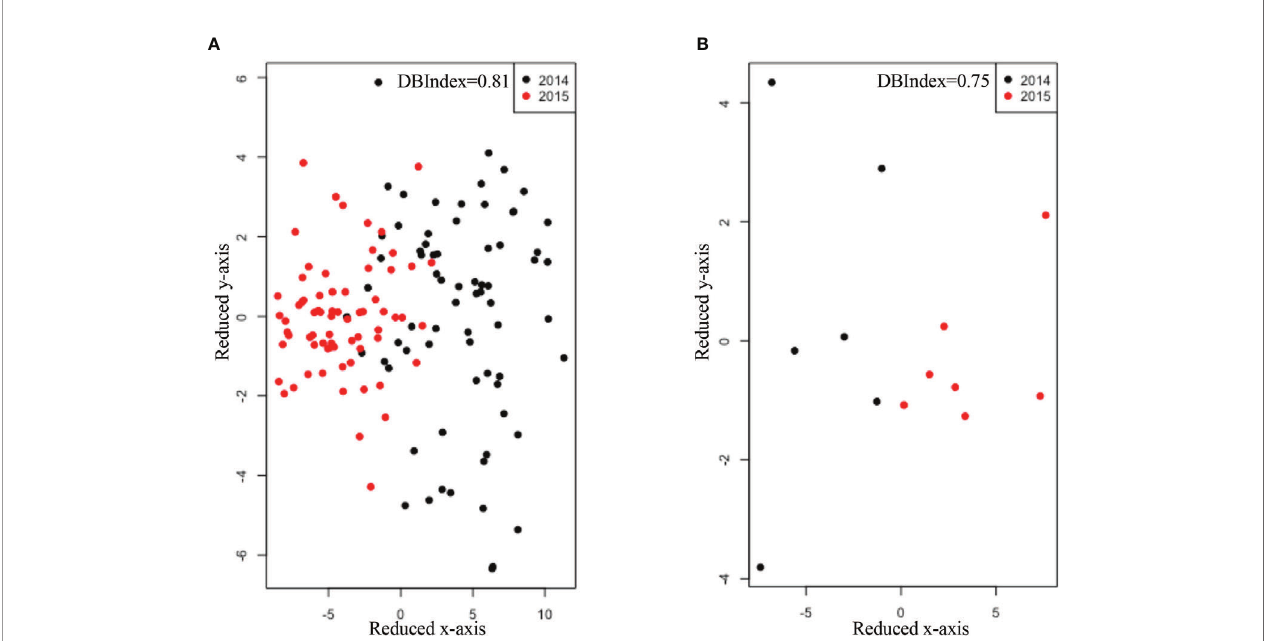
FIGURE 1 | Comparisons of host gene expression patterns using non-parametric method Isomap and DBIndex value for sampling year effect (A) among all samples (B) as well as among Stx2+ samples. Black dots and red dots refer to samples collected in 2014 and 2015, respectively. DBIndex value was shown on the right corner of each fi gure. The lower DBIndex value, the well-separated cluster pattern.